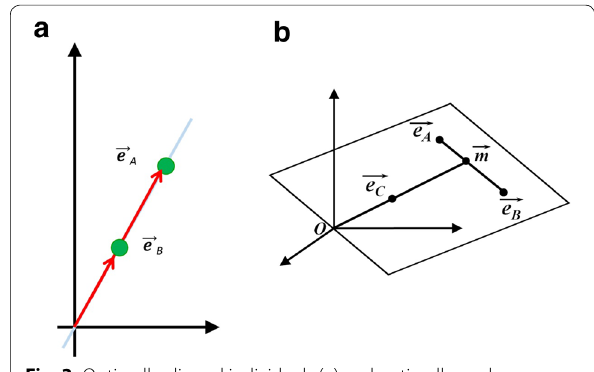
Fig. 3 Optimally aligned individuals ( a ) and optimally coplanar individuals ( b ).